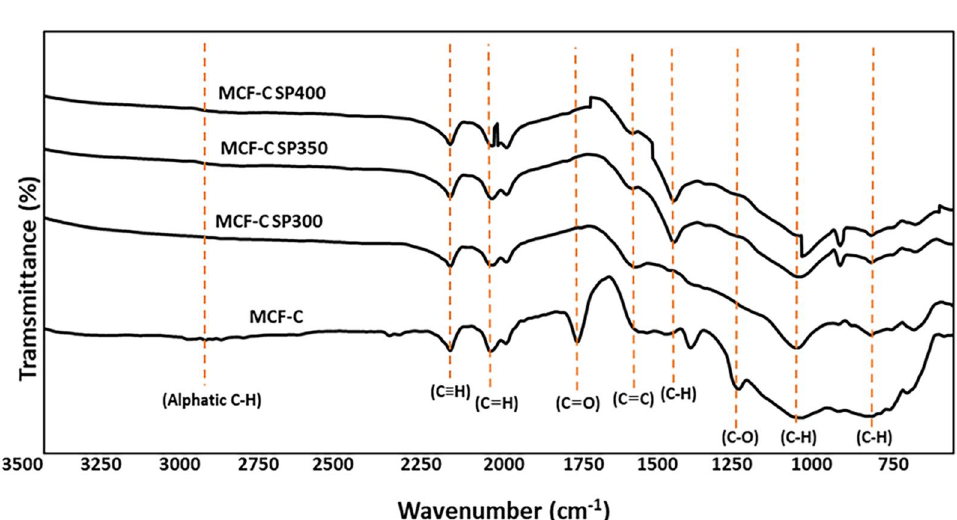
Figure 5. FT-IR spectra of the fresh and spent